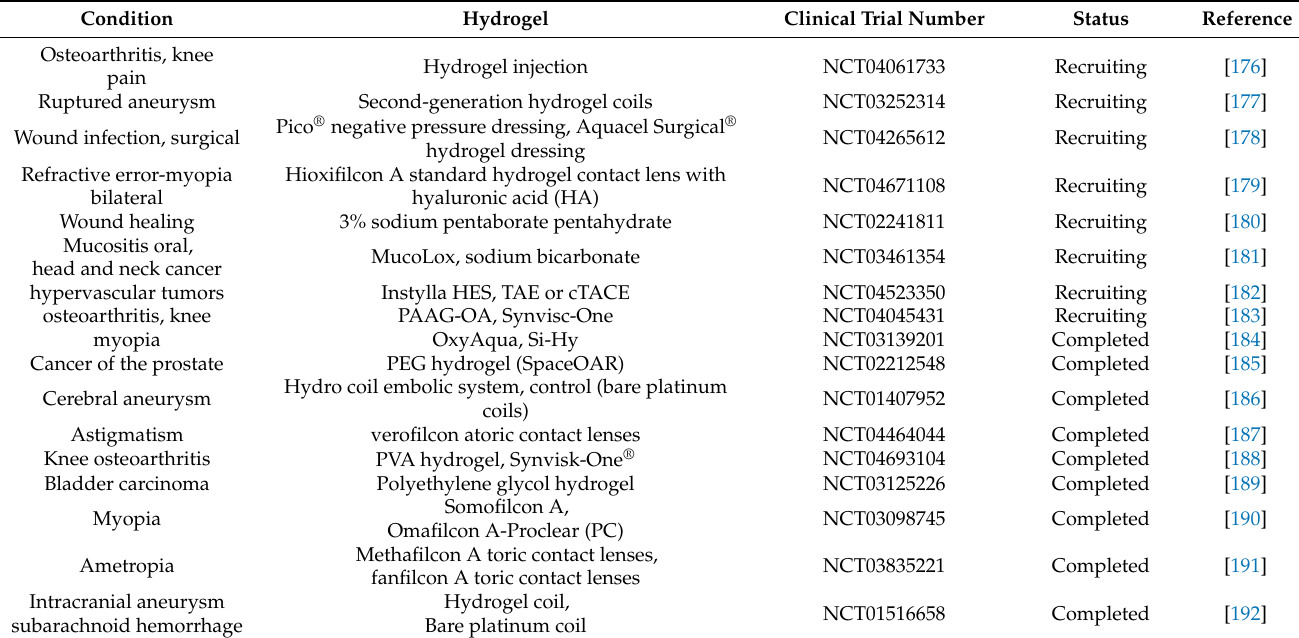
Table 3. Clinical trials on